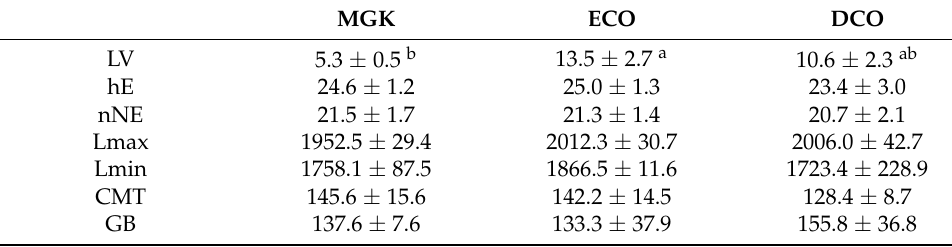
Table 7. Histological parameters measured in intestine